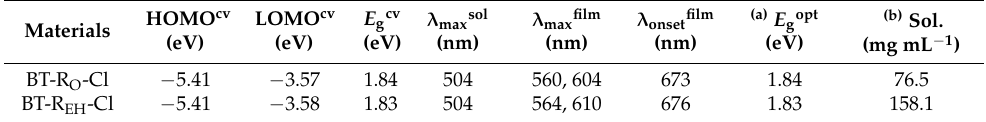
Table 1. Parameters of the optical, electrochemical, and solubility nature of BT-R O -Cl and BT-R EH -Cl.